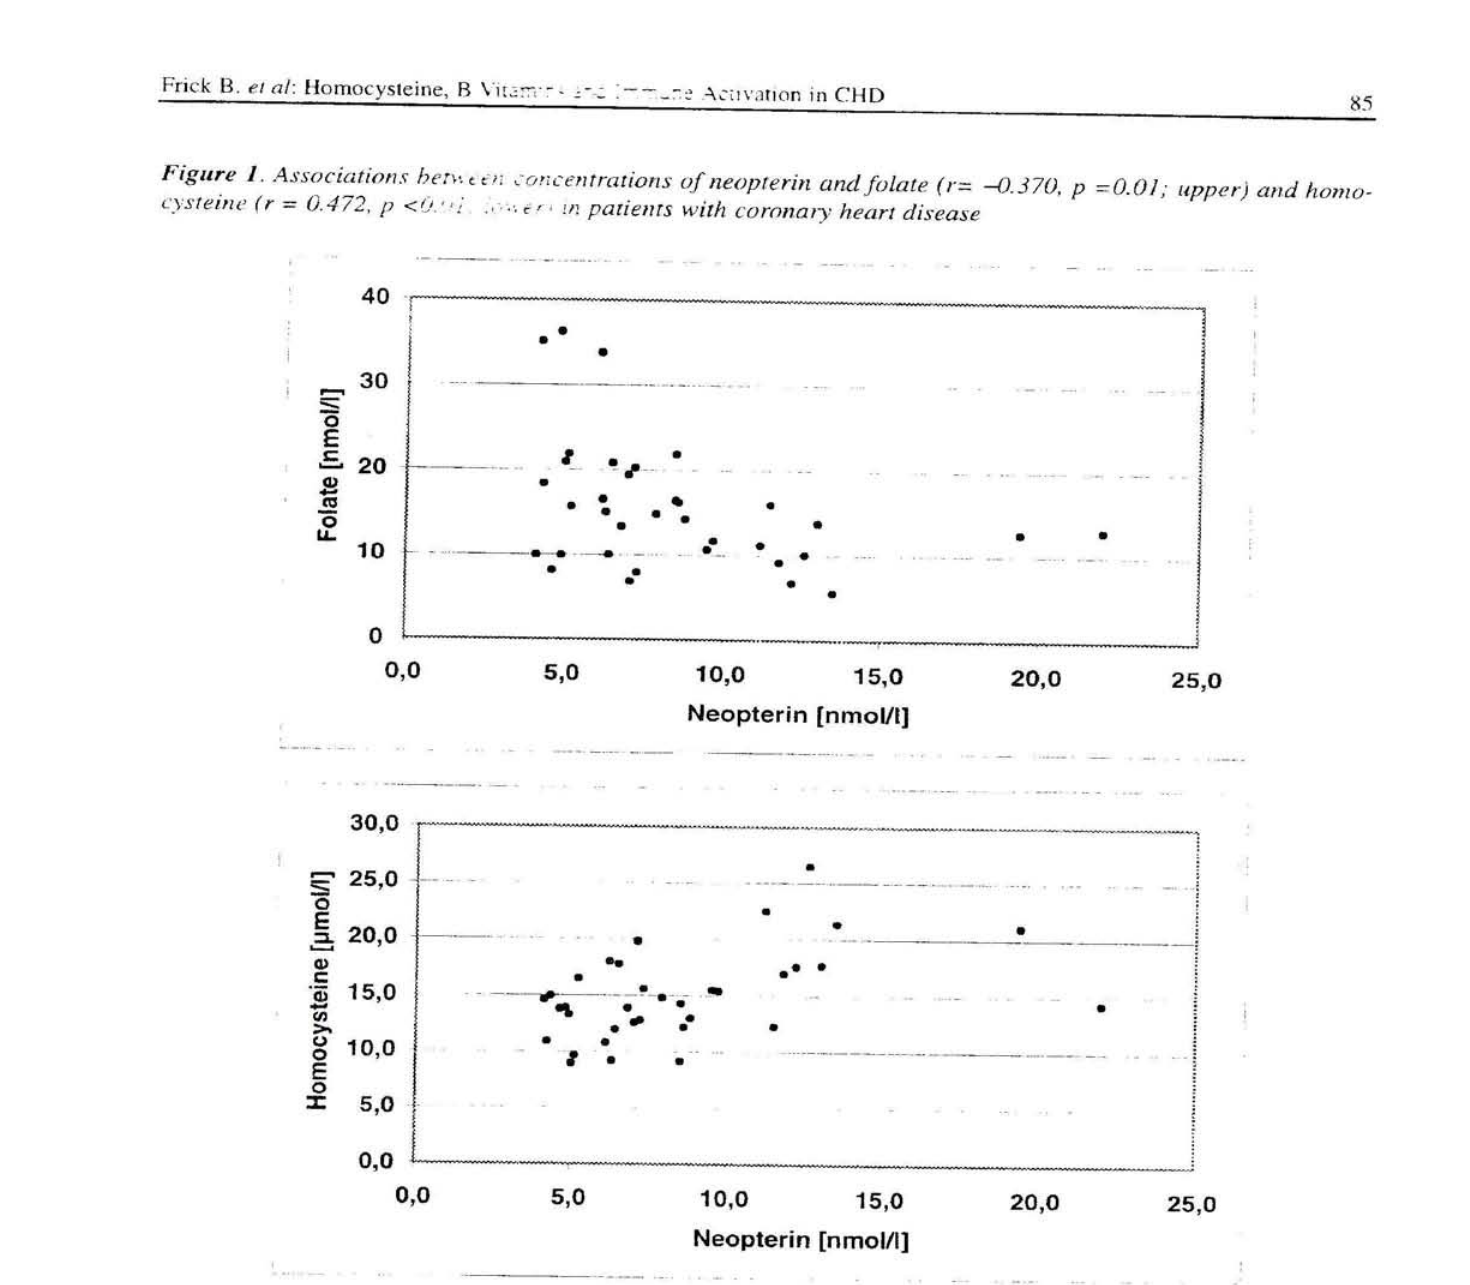
— ¿ Acnvation in CHD